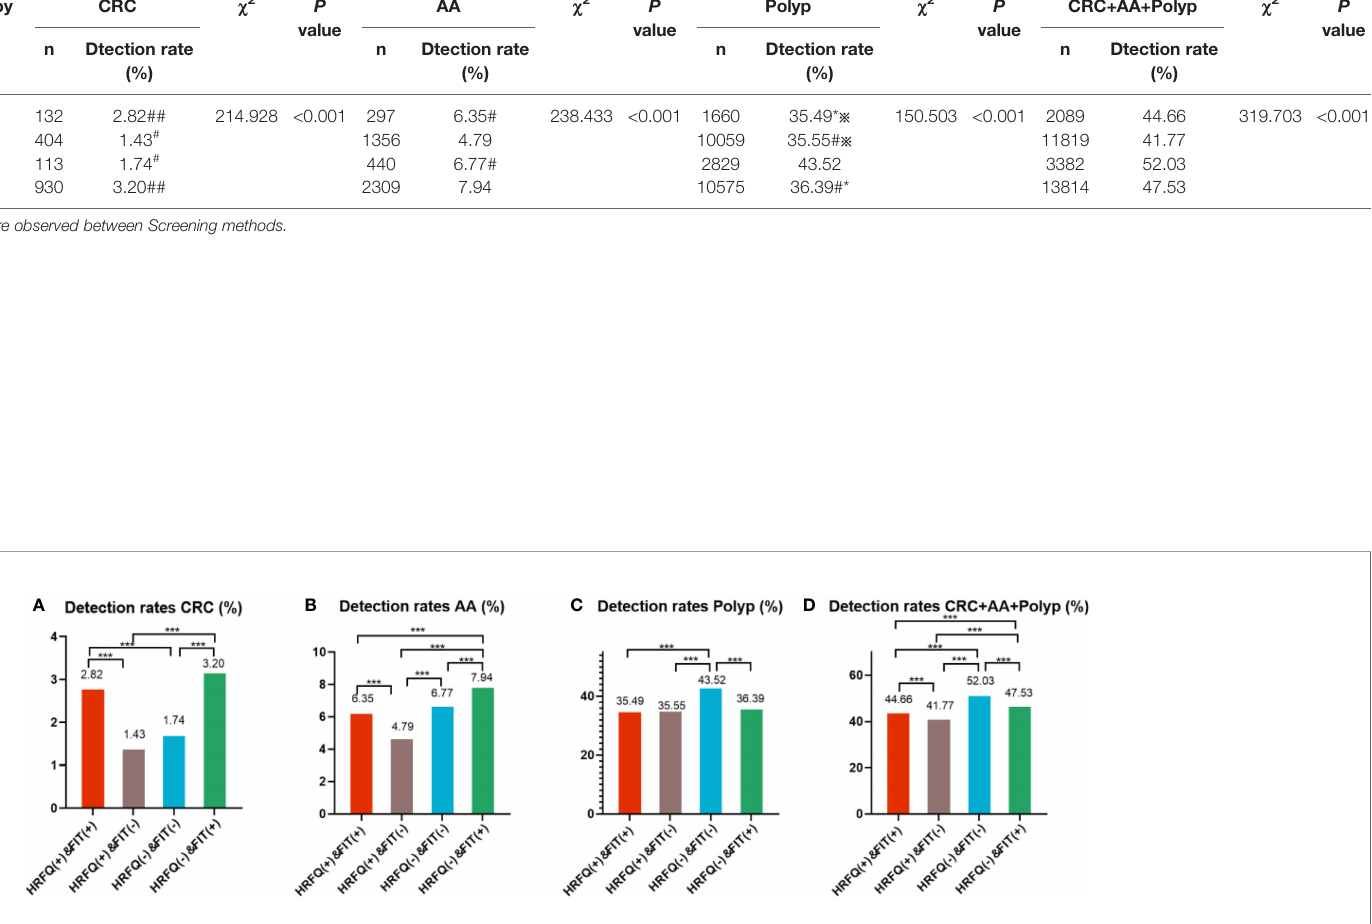
TABLE 9-4 | Comparison of colonoscopy results among different screening methods in Tianjin CRC screening program (2012-2020), (n,%). Screening methods